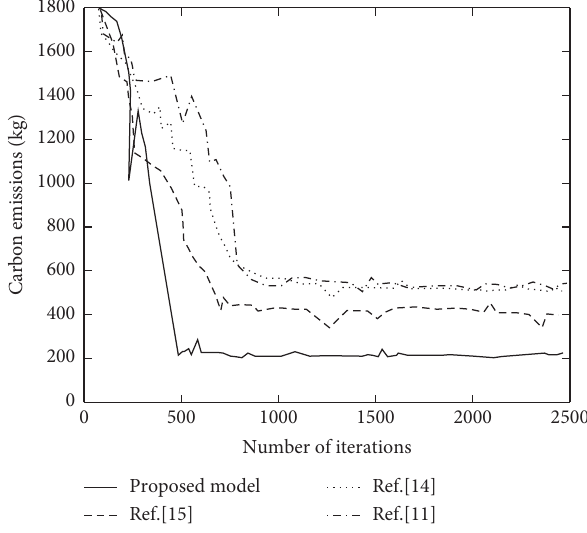
Figure 8: Carbon emissions of different